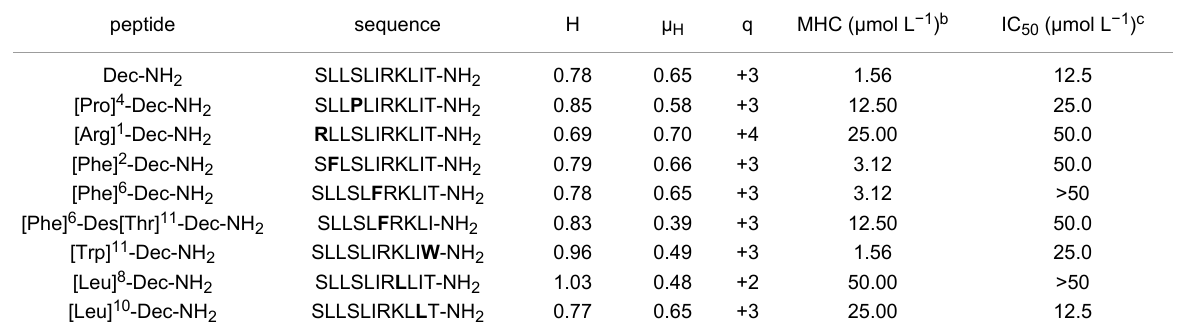
Table 1: Theoretical physicochemical properties and hemolytic activity of decoralin and its synthetic analogs. a